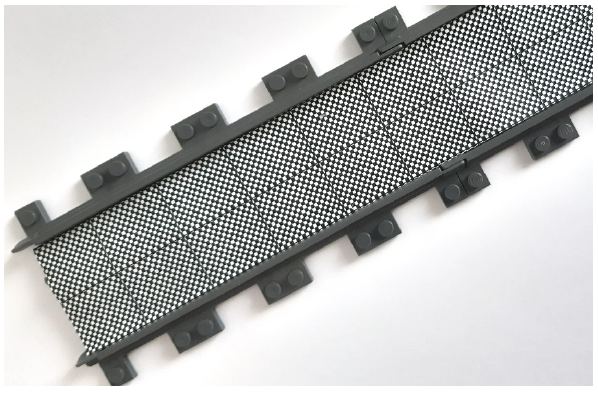
Figure 2. Tracks for the trains with checkerboard pattern for speed sensing.